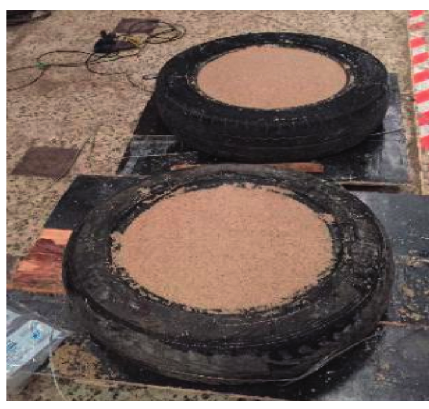
Figure 5: Tire-sand